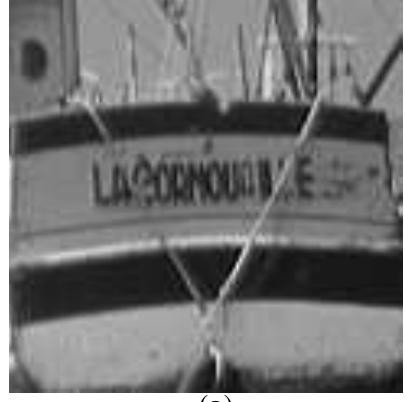
Figure 5. Comparison of subjective qualities in Boat image: ( a ) original Boat; ( b )